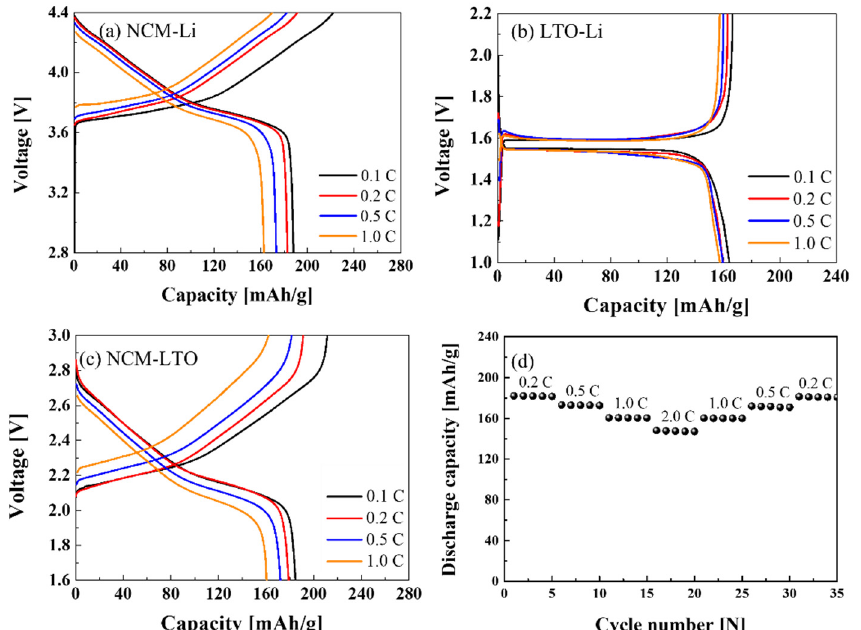
Figure 3. Electrochemical properties of ( a ) NCM-Li, ( b ) LTO-Li, and ( c ) NCM-LTO full-cells, and ( d ) rate capability of the NCM-LTO full-cell at various C-rates.